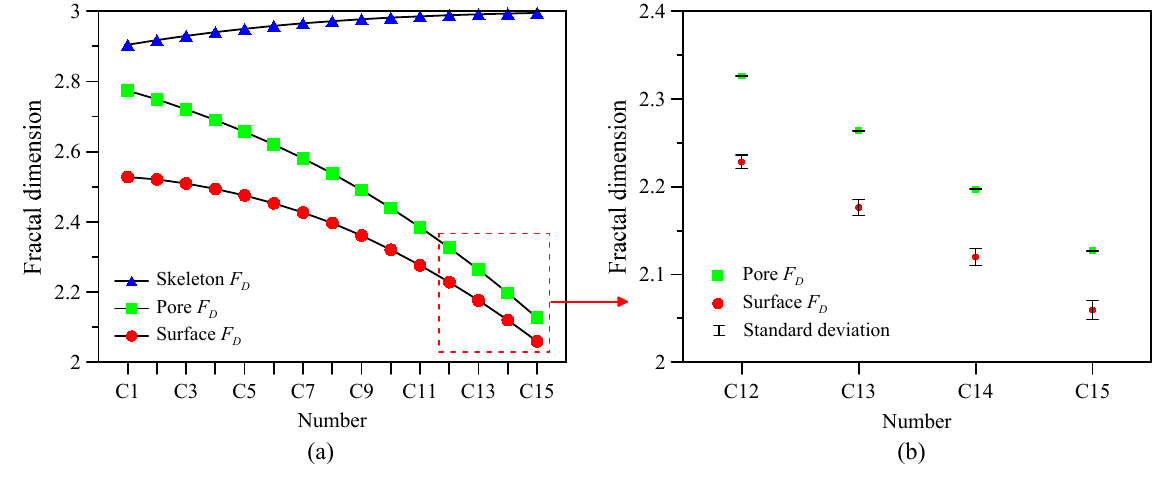
Figure 8. Fractal dimension evolution of cementation model. ( a ) Three kinds of fractal phases; ( b ) Magnification of fractal dimension and standard deviation of some sub-models.